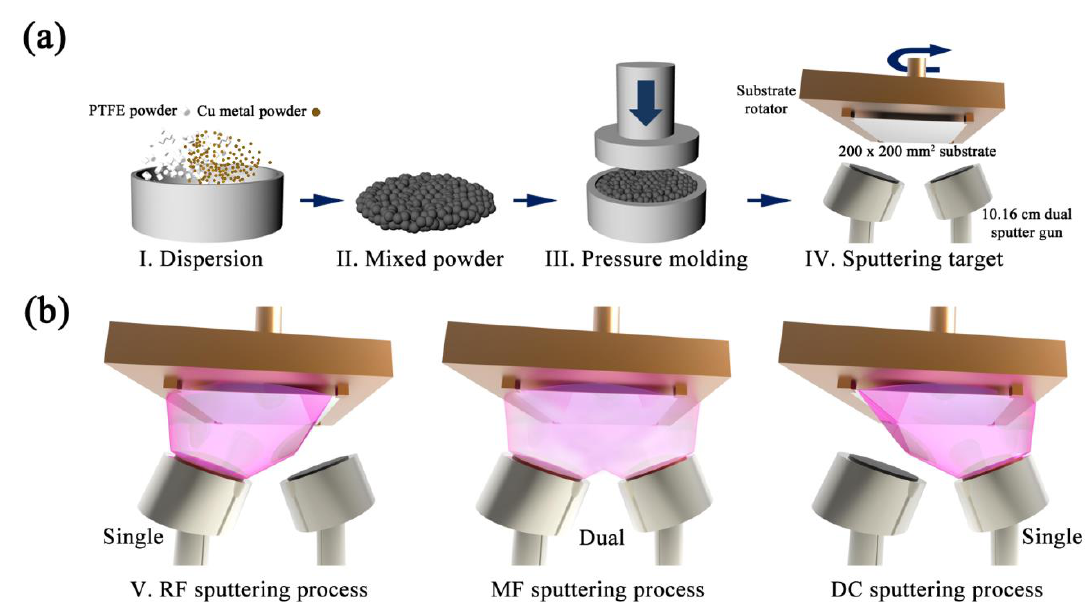
Figure 1. ( a ) Sequential diagram of the fabrication of Cu/PTFE composite target. ( b ) Illustration of the sputtering process to deposit Cu/plasma polymer fluorocarbon (PPFC) nanocomposite thin films with radio frequency (RF), mid-range frequency (MF), and direct current (DC) power sources.